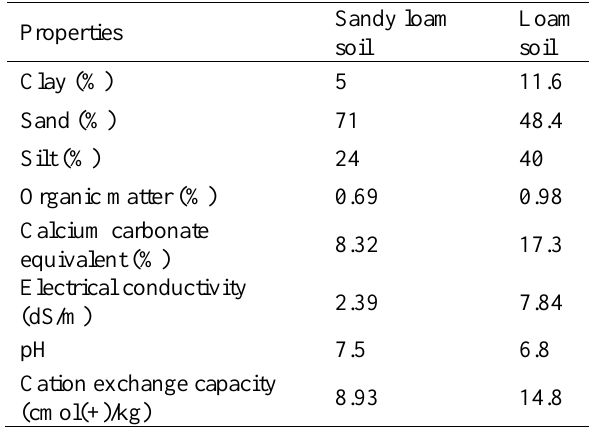
Table 1. Selected chemical and physical properties of studied